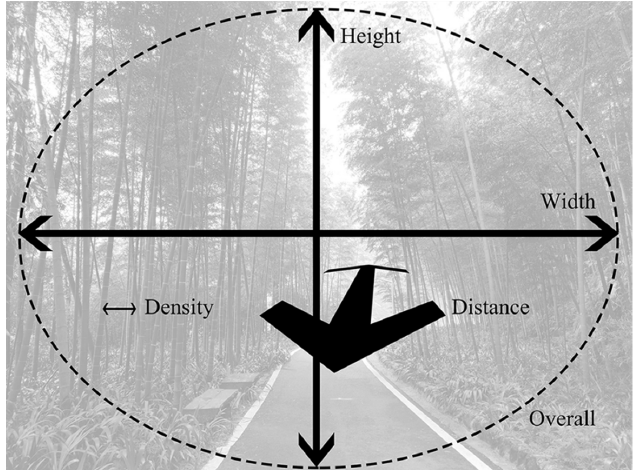
Figure 4. Five parts of the spatial scale in the bamboo forest space.